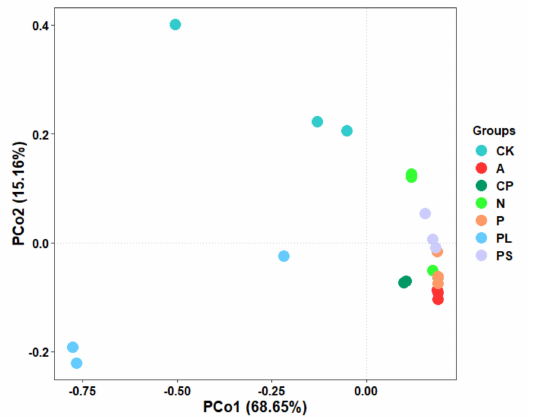
Figure 5. Principal coordinate analysis (PCoA) based on the Bray − Curtis distance between different host diets. CK, artificial diet; A, apple-feeding; CP, crisp pear-feeding; N, nectarine-feeding; P, peach-feeding; PL, plum-feeding; PS, peach